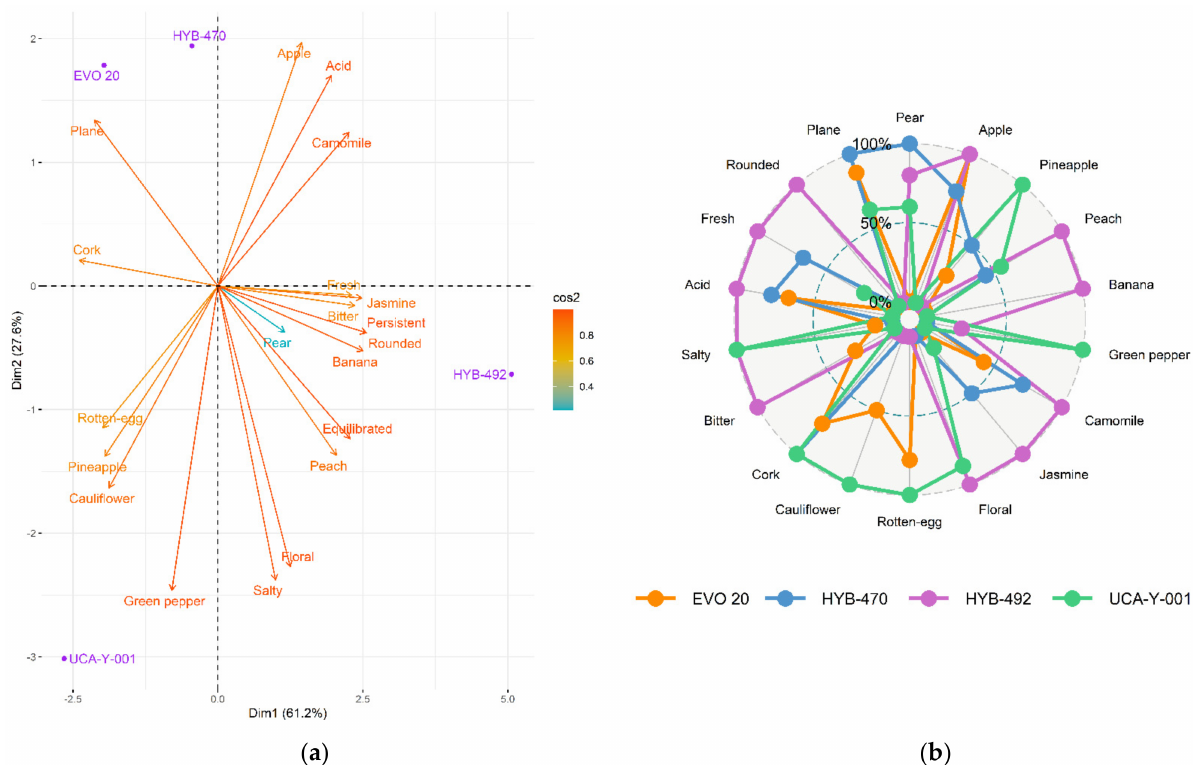
Figure 5. Sensory characterization of Palomino Fino white wines fermented with the different yeast strains studied (UCA-Y-001, EVO-20, HYB-470, and HYB-492) by Napping ® : ( a ) PCA (on the plane, PC1 against PC2); ( b ) spider graph of the principal attributes in the obtained